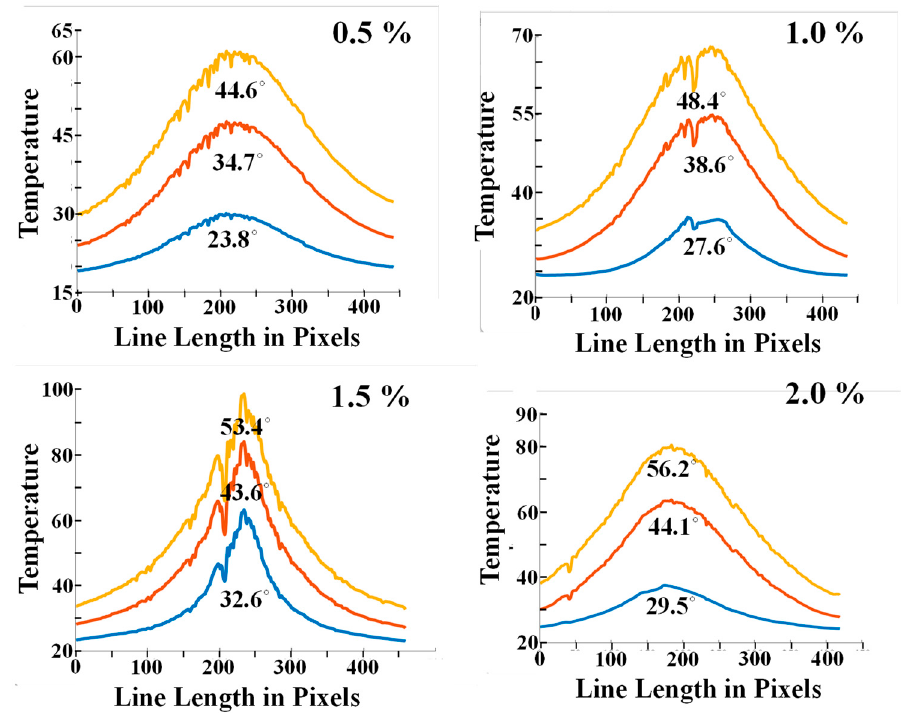
Figure 9. The temperature distribution pattern of along the line representing the lowest temperature multizone. The number in each curve represents the average temperature of the area covered by